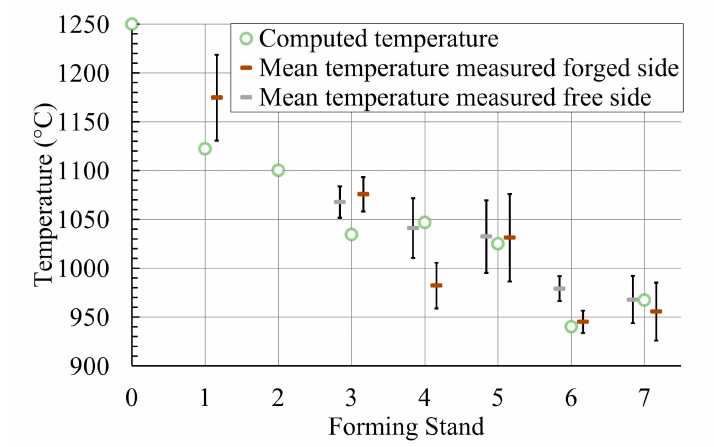
Figure 5. Maximum computed temperatures (reference parameter) and mean maximum temperature measured on the representative